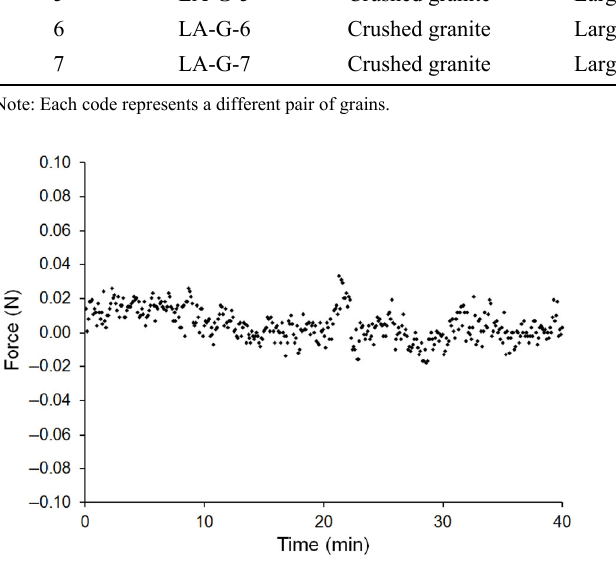
Fig. 8 Noise in the large-size apparatus. Displacement from the eddy-current sensor is recorded against time.